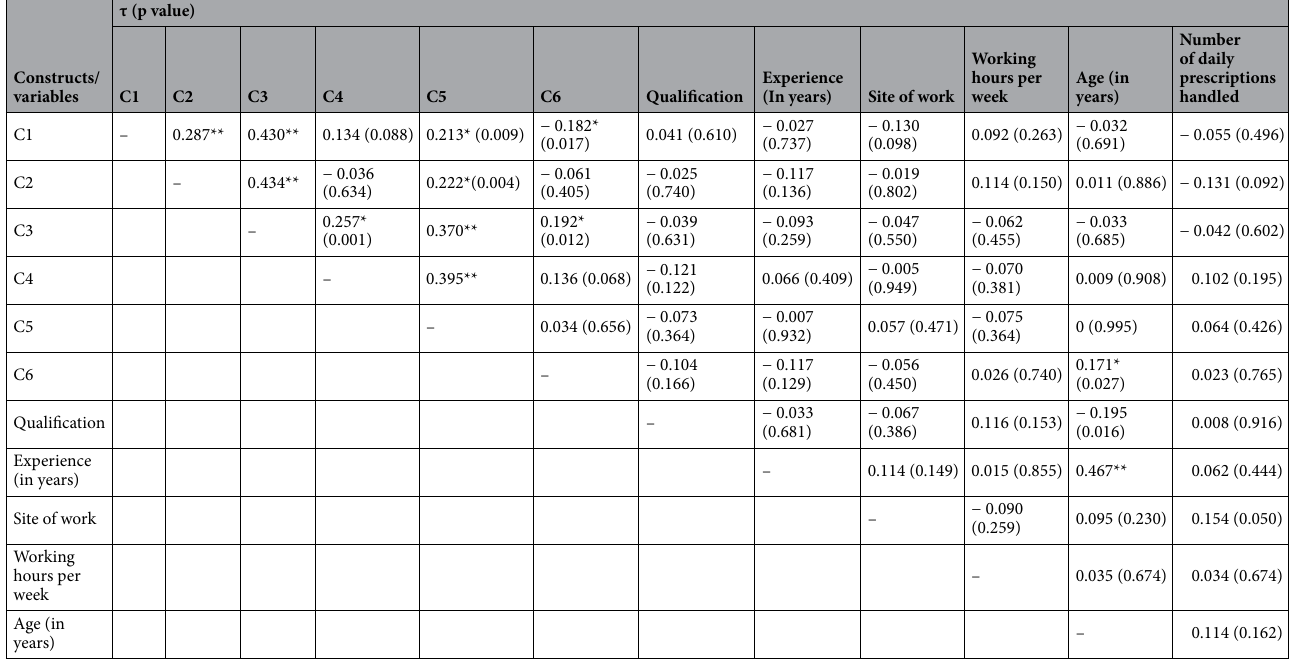
Table 9. Correlation among different perception-related constructs and other variables. C1: Patient’s medications should be reviewed to prevent medicine-related errors and promote appropriate use of medications. C2: All patients receiving medicines require PC. C3: PC can improve patient’s treatment or health outcome. C4: Pharmacists are professionally skilled HPs in providing PC. C5: Pharmacists are responsible for the identification, prevention and resolution of MRPs. C6: Continuing pharmacy education is NOT essential to equip pharmacists to provide PC. C: Construct; τ: Kendall’s correlation (Tau). **p value <